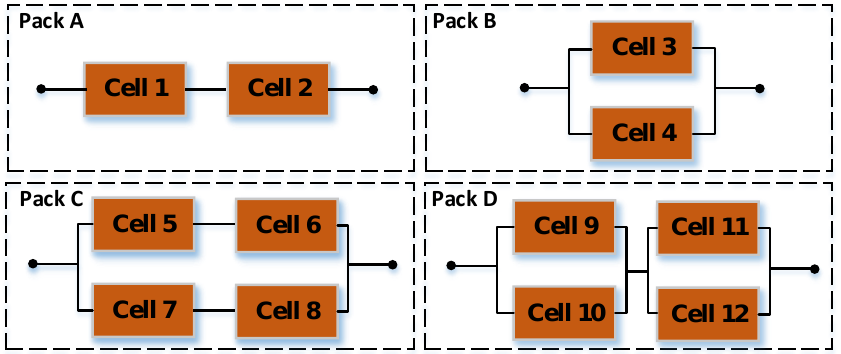
Figure 1. Configurations of the four battery packs.